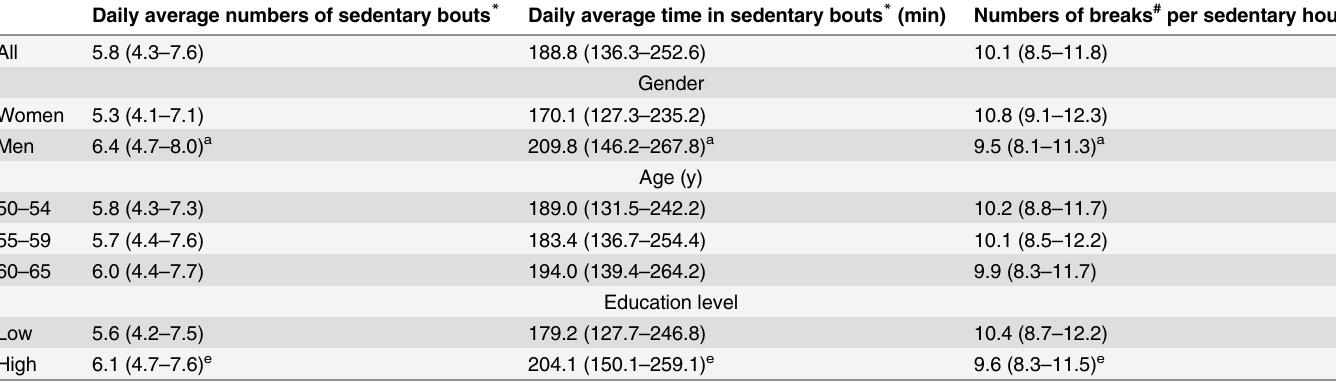
Table 4. Characteristics of sedentary behaviour among all study participants and in subgroups.